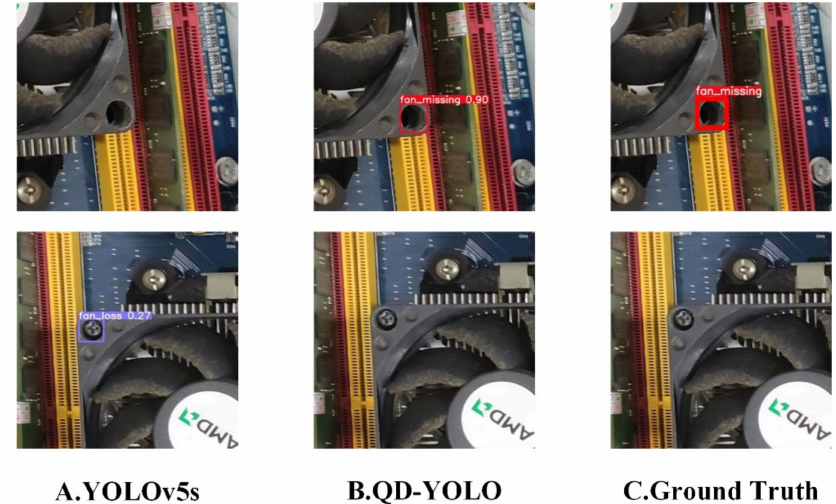
Figure 9. Comparison of actual detection results.